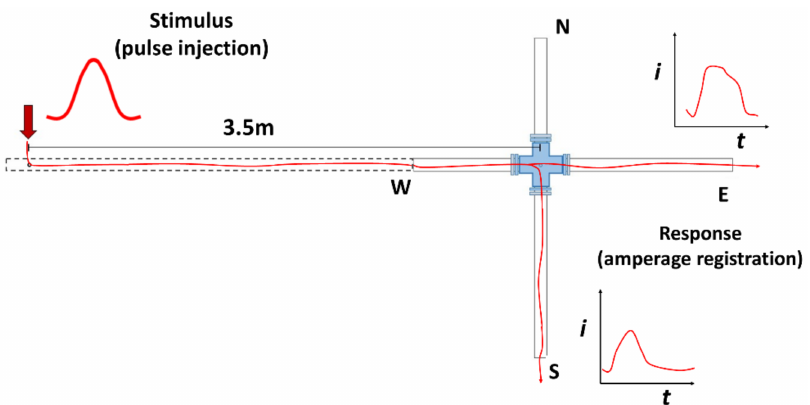
Figure 3. Tracer injection and registration points.